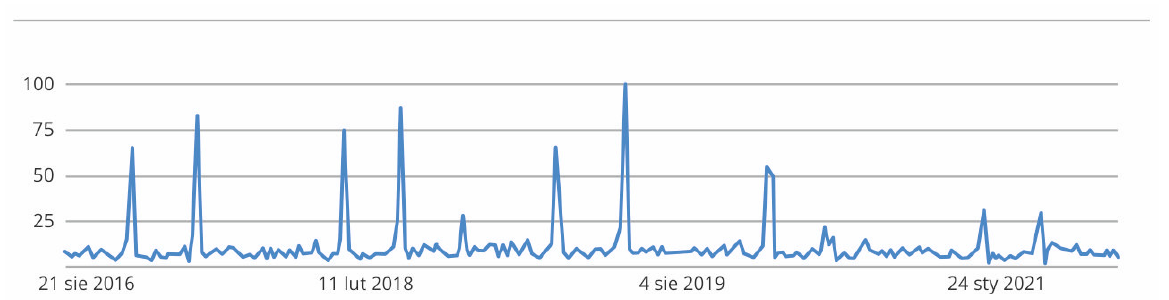
Figure 9. Frequency of searches for “prayer” over the last five years by region. Google Trends,